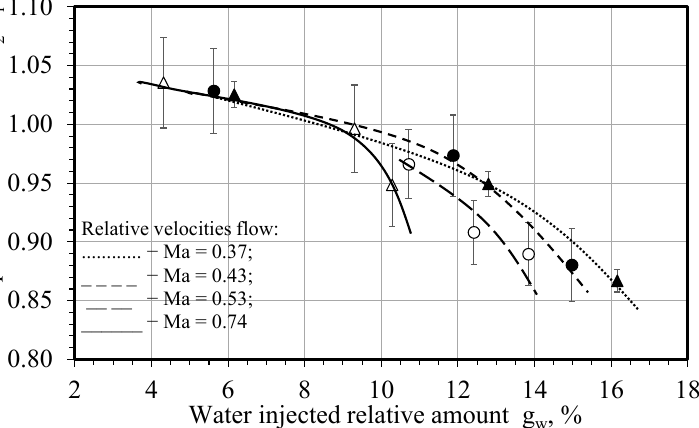
Figure 10. The relative pressure increase measuring error at the availability of evaporation ε tp from the water injected relative amount g w .